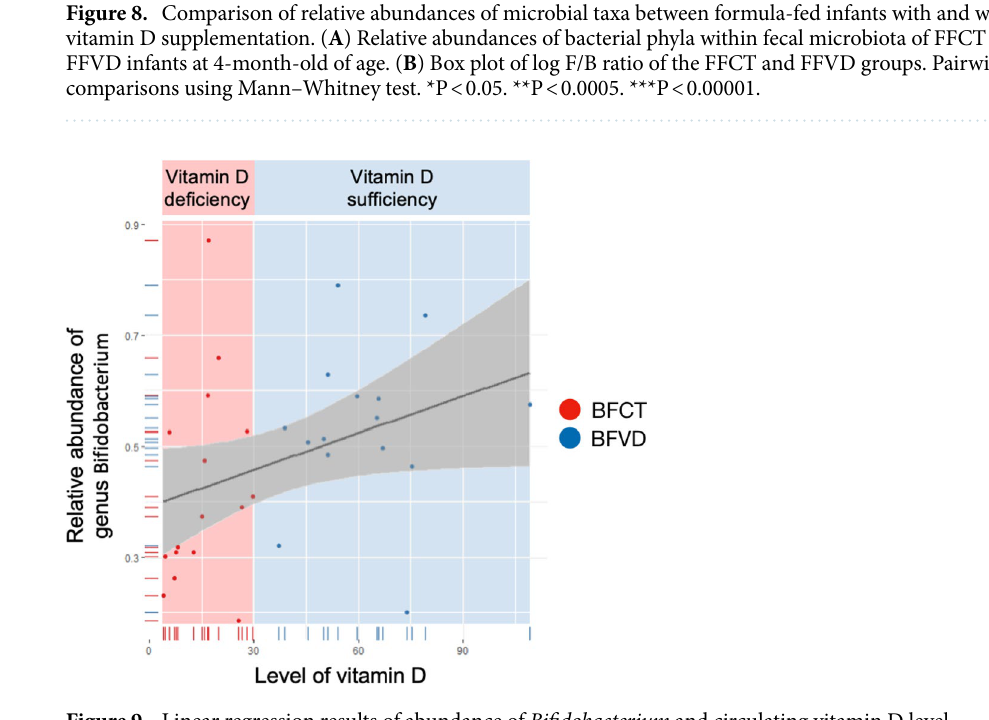
Figure 9. Linear regression results of abundance of Bifidobacterium and circulating vitamin D